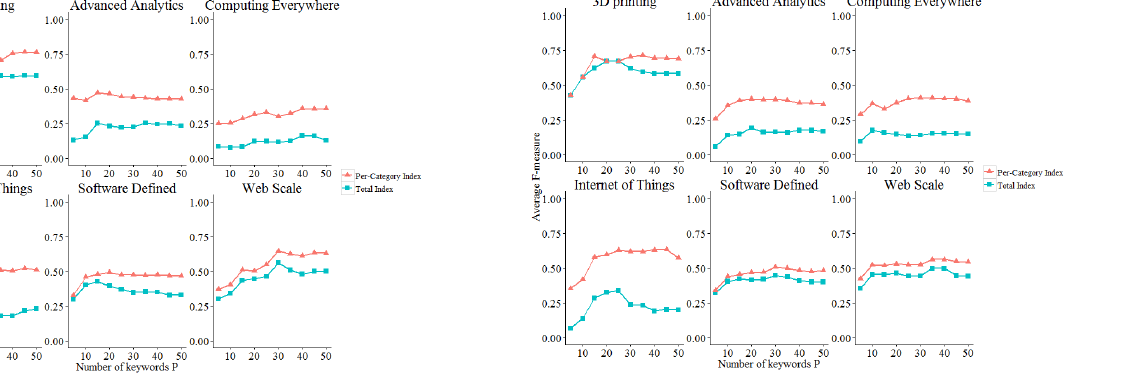
Fig. 11. Indexing Structure Evaluation In TFIDF - Average F- measure in each category across the number of keywords (P) (red line: Per-Category Index, blue line: Total